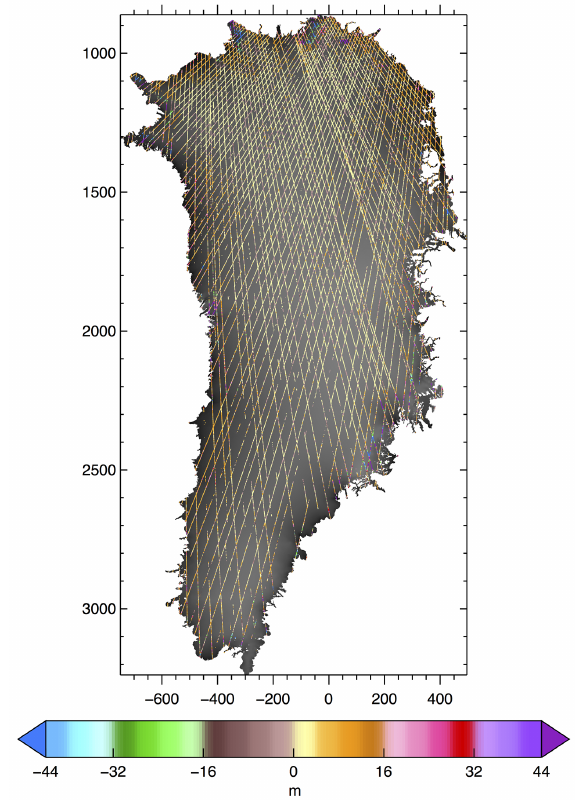
Figure 5. Map of ICESat minus modeled surface elevation differ- ences (m) in 2007.8 for the SMB + FF simulation. Colored lines mark locations of ICESat observations. Gray areas represent regions where no ICESat observations are available.